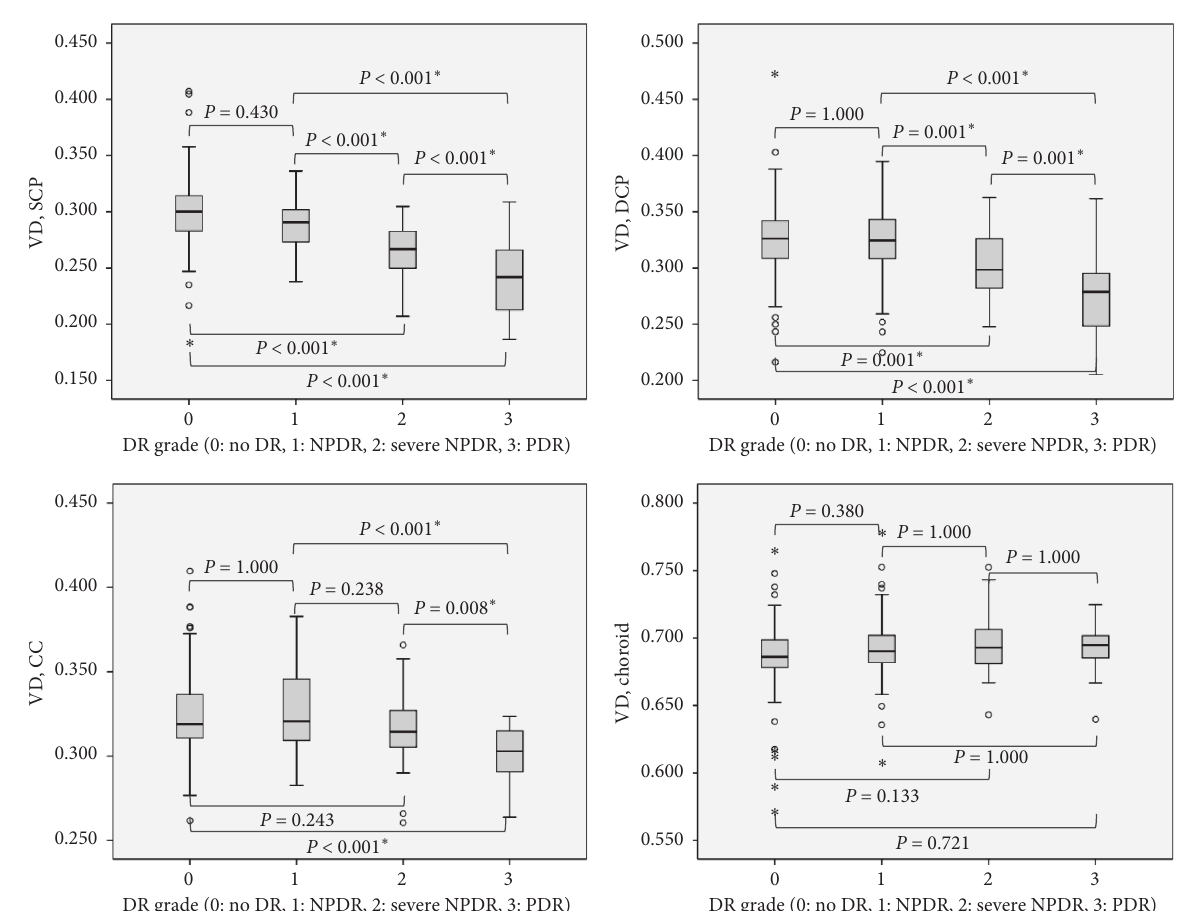
Figure 2: Comparison of vessel densities and grades of diabetic retinopathy (DR). Vascular densities (VDs) of superficial vascular complex (SVC), deep vascular complex (DVP), and choriocapillaris differed based on DR grades (all P < 0 . 001). Post hoc analysis showed that severe nonproliferative diabetic retinopathy (NPDR) and proliferative diabetic retinopathy (PDR) eyes had lower VDs of SVC and DVC compared with their previous grades (all P < 0 . 001). PDR eyes also showed lower choriocapillaris VD compared with lower DR grades (all P < 0 . 008). ∗ Statistically significant P